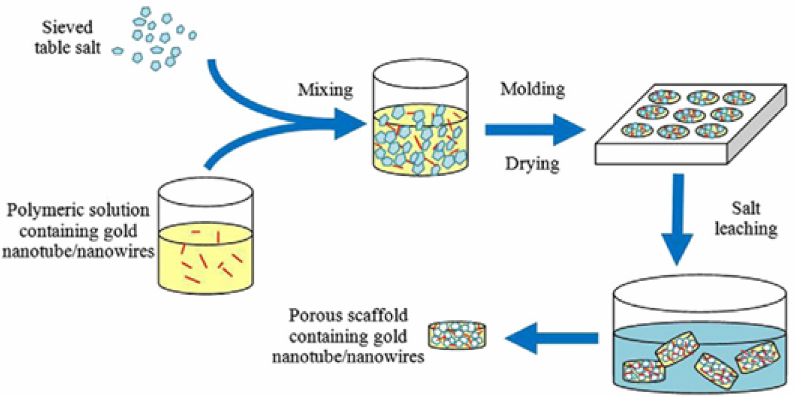
Figure 2. Schematic of the scaffold preparation. Reprinted from [49] with permission from